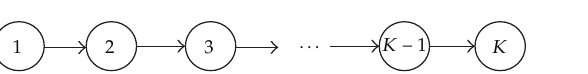
Figure 1: The illustration of an intercity rail